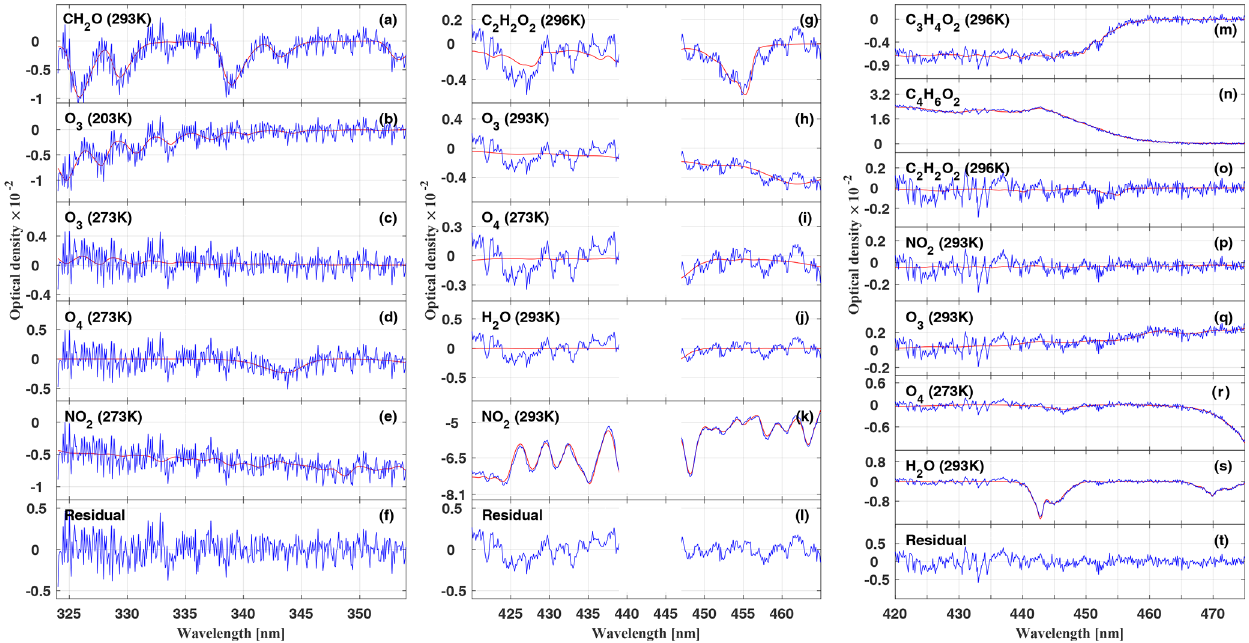
(m–t) for the measurements at 17:16, 15:06, and 2